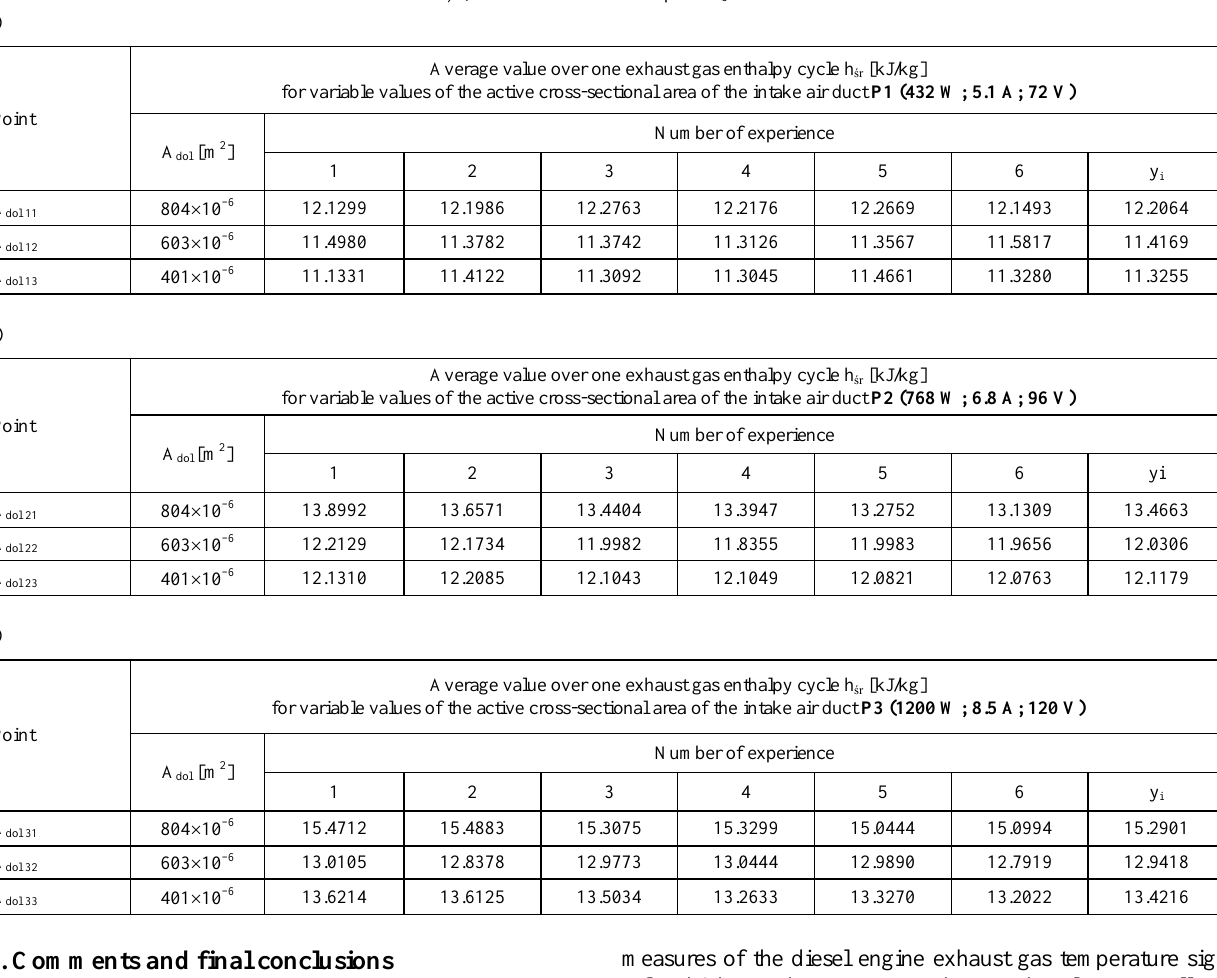
Table 3. Values of the specific enthalpy of the exhaust gas stream h spalśr within one diesel engine cycle for the variable values of the active cross-sectional area of the A dol intake air channel, where: a) the result for the test at point P 1 = 432 W of the control characteristic, b) the result for the test at point P 2 = 768 W of the same characteristic, c) the result for the test at point P 3 = 1200 W of the above